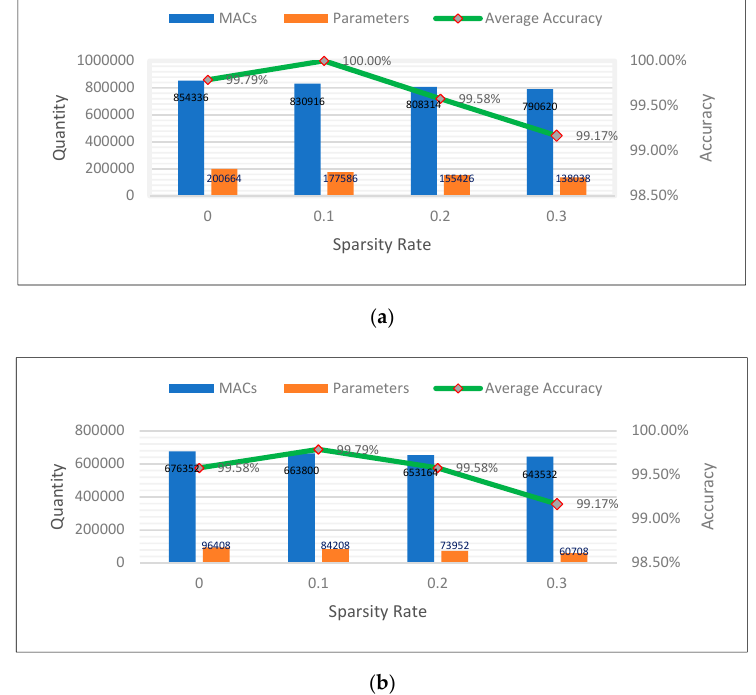
Figure 6. Results of after training and pruning model at different sparsity rates and scaling rates: ( a ) 0.2×MobileNet-v2 (scaling rate = 0.2), ( b ) 0.1×MobileNet-v2 (scaling rate = 0.1).